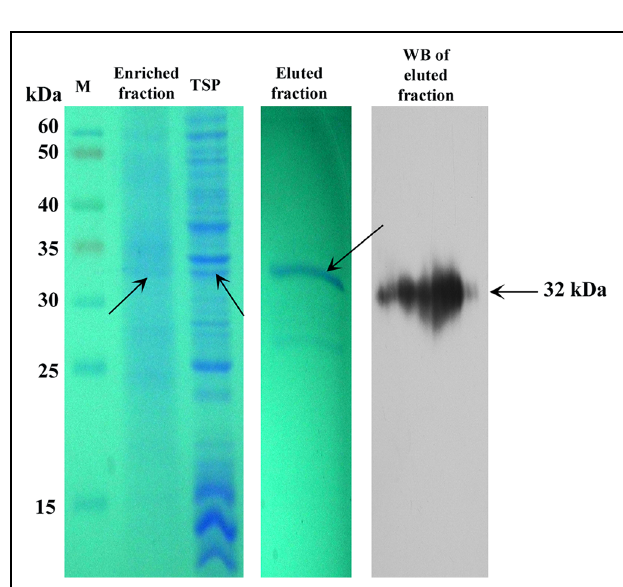
FIGURE 6 | Proteolysis assay. Trypsin digestion of recombinant SAC-Par-4 protein for various time increments and Western blot analysis using anti-Par-4 antibody of (A) apoplast-targeted SAC-Par-4-GFP protein of transgenic line L3; (B) bacterial derived SAC-Par-4. Each lane contains the starting equivalent of approximately 500 ng total protein. The position of the molecular weight marker (M) is indicated.